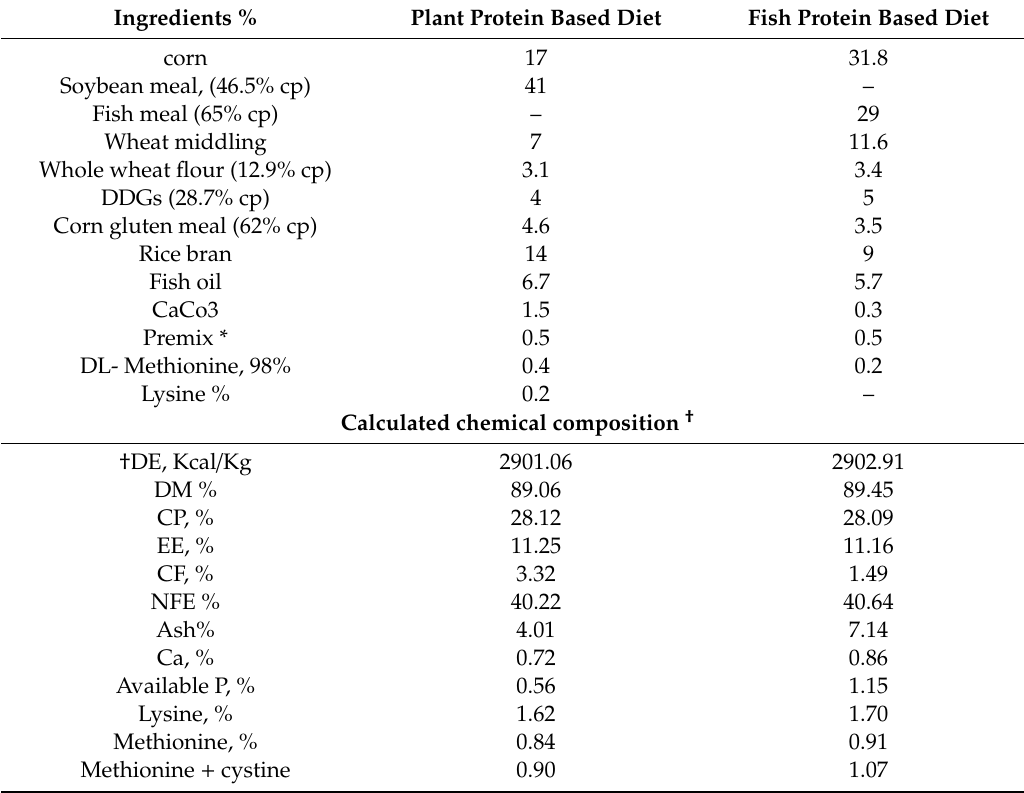
Table 1. Feed stu ff and chemical composition of the control diets (as fed